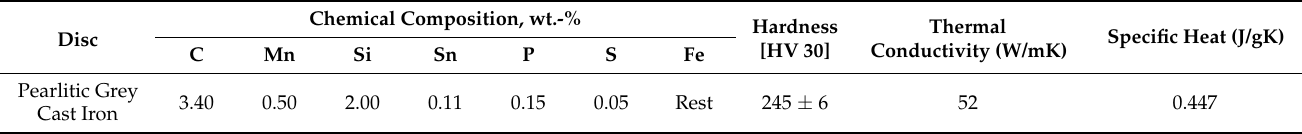
Table 3. Properties and composition of the pearlitic grey cast iron counterface